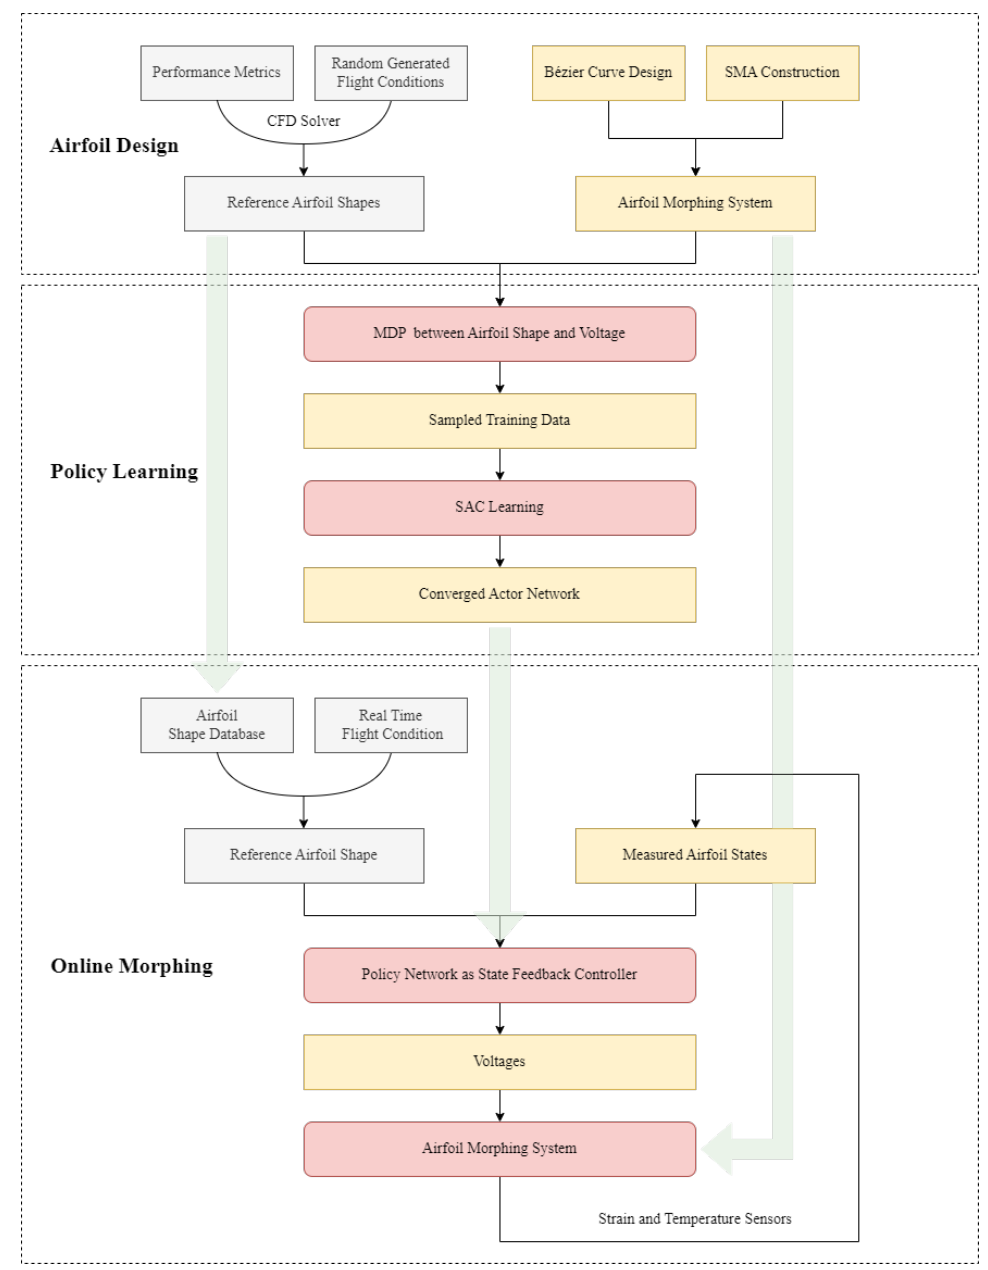
Figure 4. Overall flowchart of the proposed DRL-based airfoil morphing